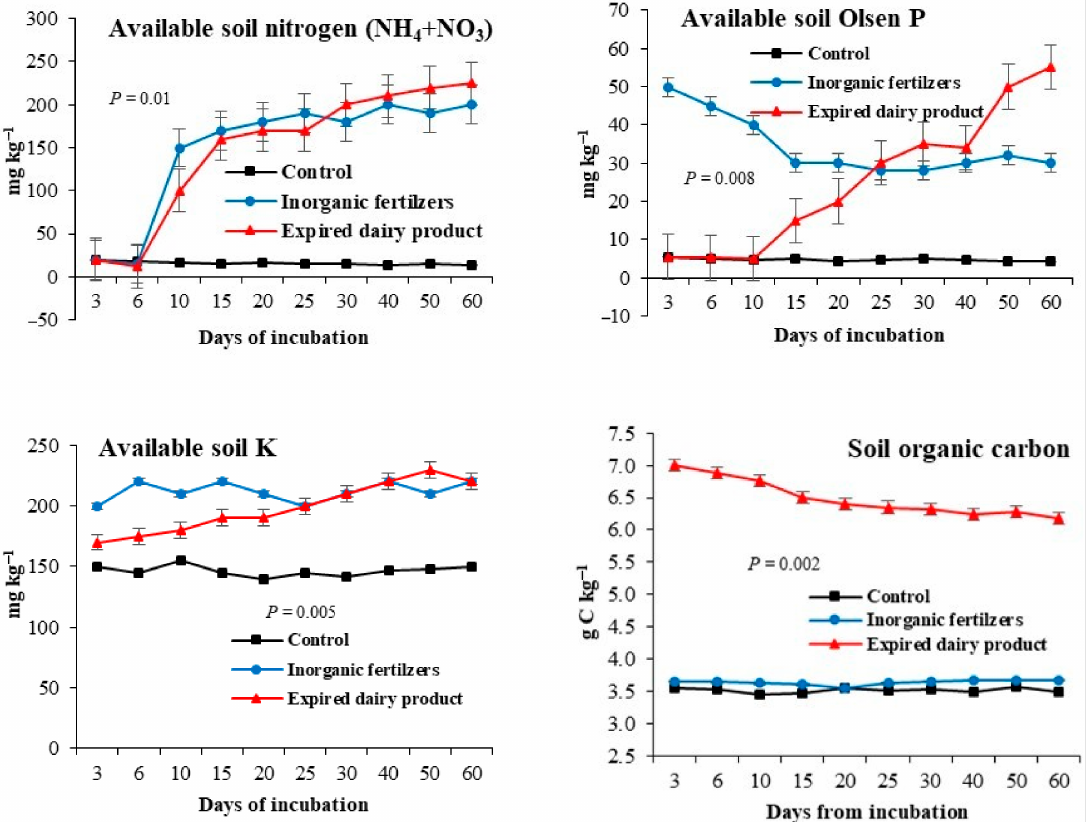
Figure 2. Effect of organic and inorganic fertilization on nutrients release and soil organic carbon. P = the p -value of the ANOVA